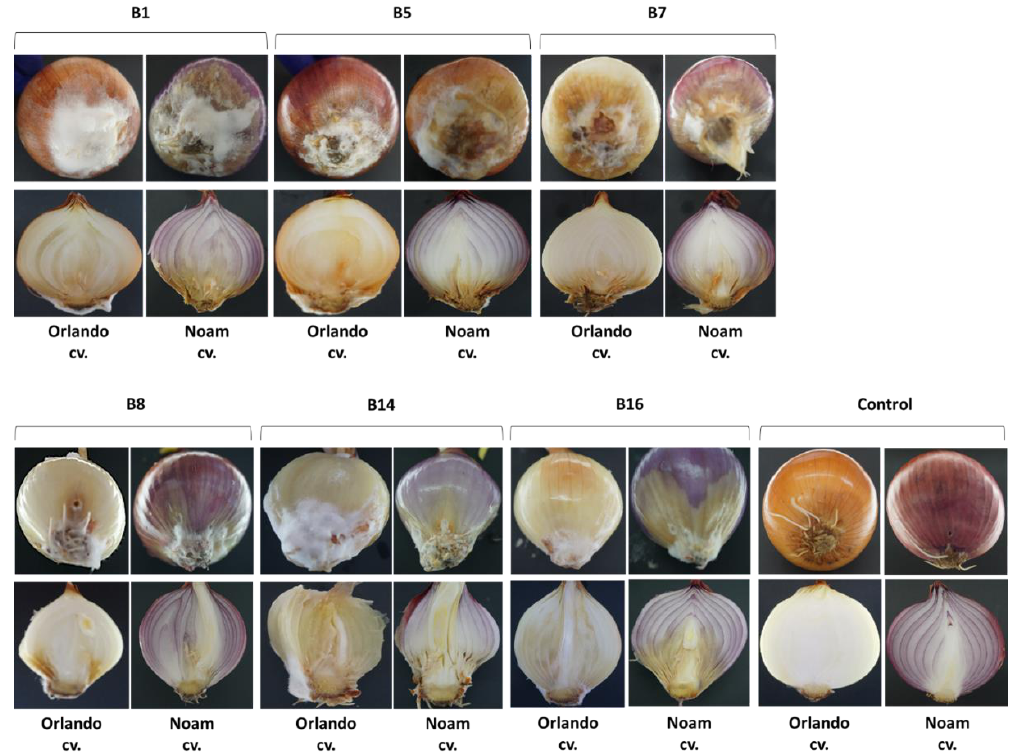
Figure 9. Onion bulb pathogenicity assay. Onion bulb inoculation assay was conducted on Riverside (Orlando) and Noam cultivars by injecting a conidial suspension of the six Fusarium isolates (Table 2) into the basal plate and incubating the bulbs in moisture bags in the dark at 28 ± 1 °C for two weeks. Upper panel—external symptoms on the onion basal plate. Lower panel—a cross-section of the bulbs. The disease symptoms included onion tissue decay, accompanied by the development of white hyphae on the external surface.